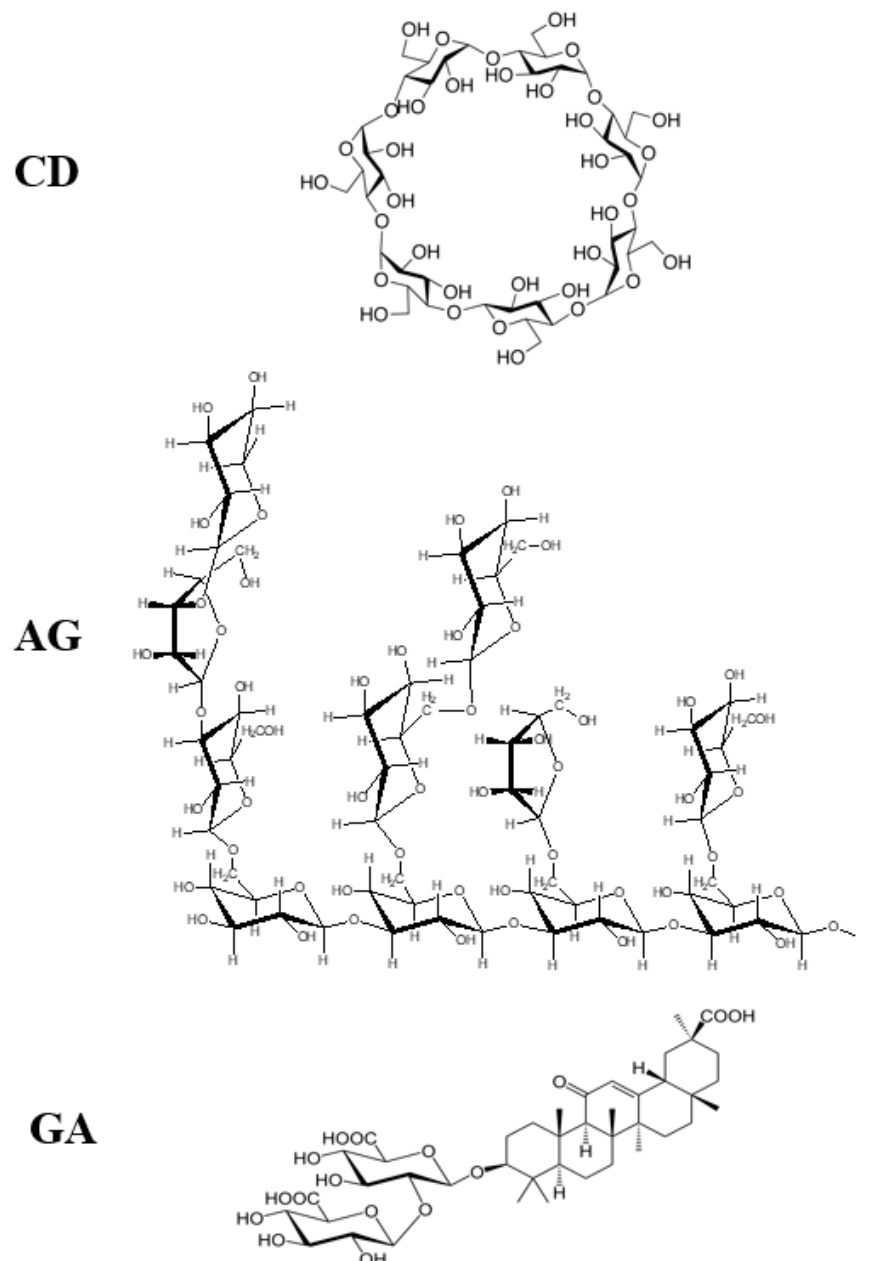
Figure 1. Structures of cyclodextrin (CD), arabinogalactan (AG) and β -glycyrrhizic acid (GA).